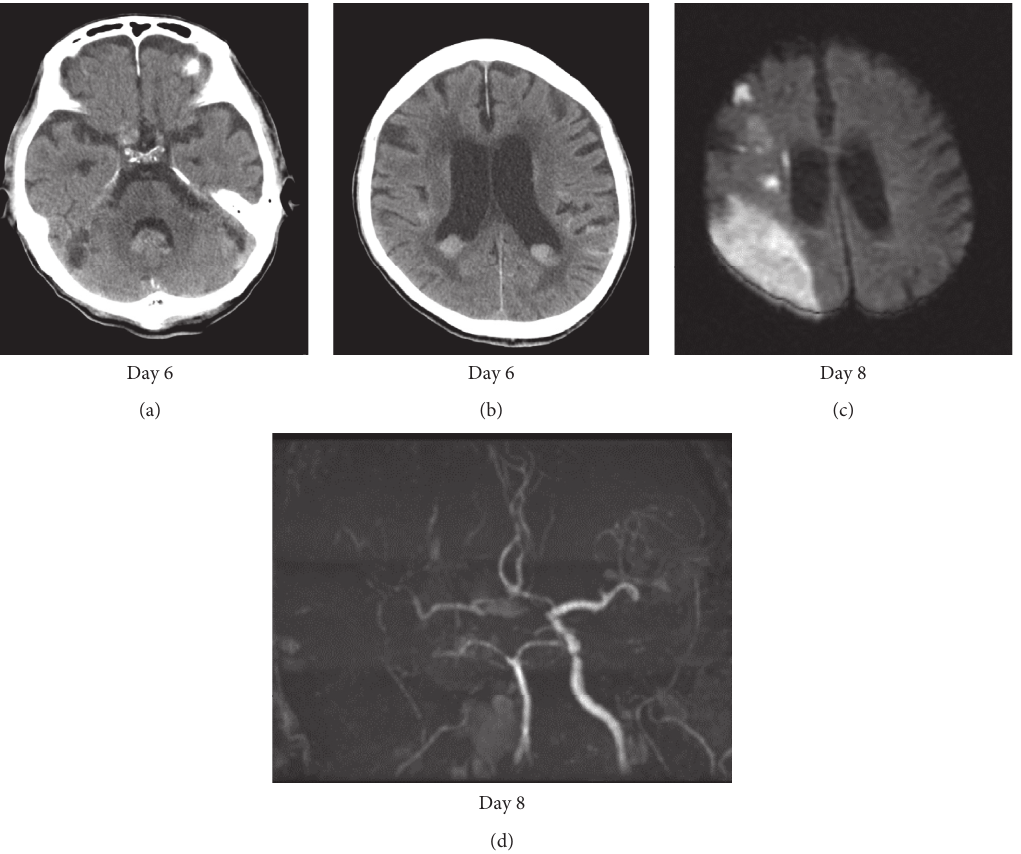
Figure 3: Day 6: head CTshowing a subarachnoid hemorrhage (a), (b). Day 8: brain MRI showing a right middle cerebral artery infarction on DWI (c) and MRI showing right internal carotid artery occlusion